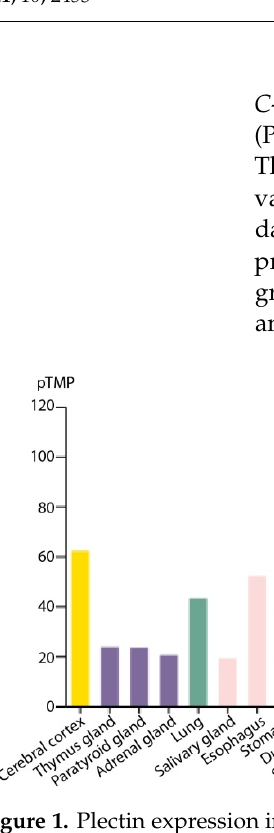
Figure 1. Plectin expression in different tissues. The expression data have been downloaded from the tissue atlas of the Human Protein Atlas (https://www.proteinatlas.org/ENSG00000178209-PLEC/tissue, accessed on 1 June 2021). The data are based on deep sequencing of RNA from 37 major different normal tissues types [9] . TPM, transcripts per million, used as normalization value.